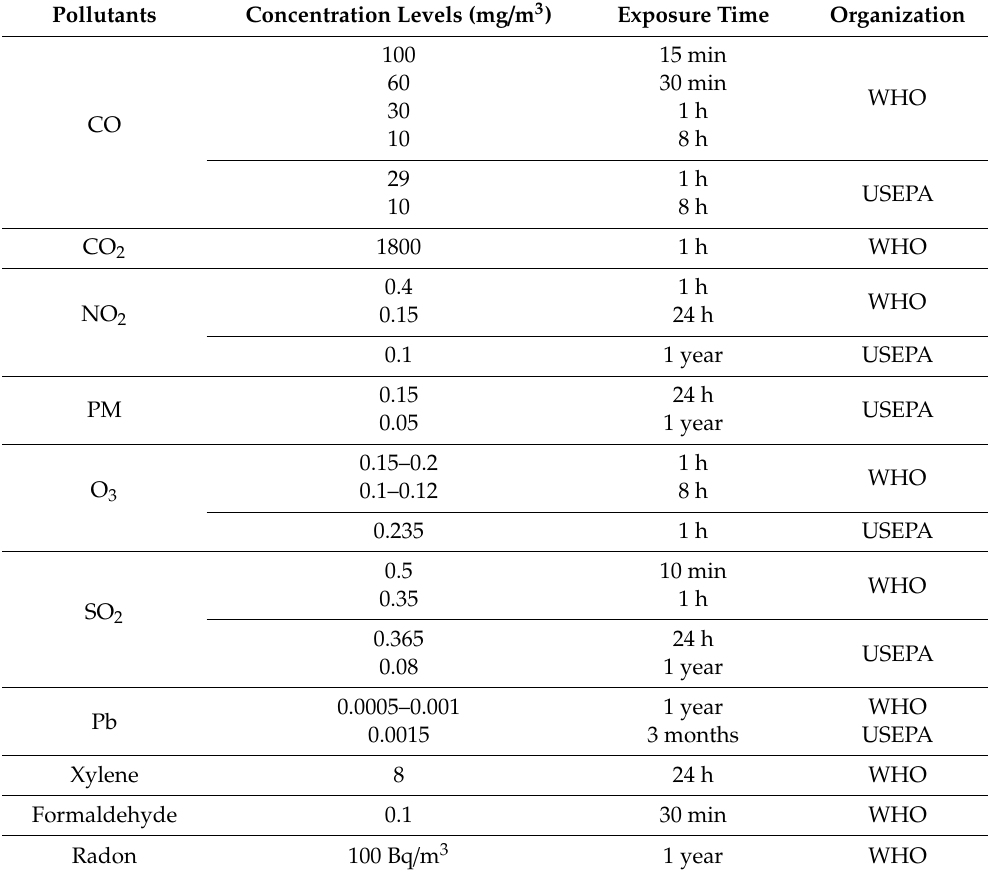
Table 2. Indoor air quality guidelines for major indoor air